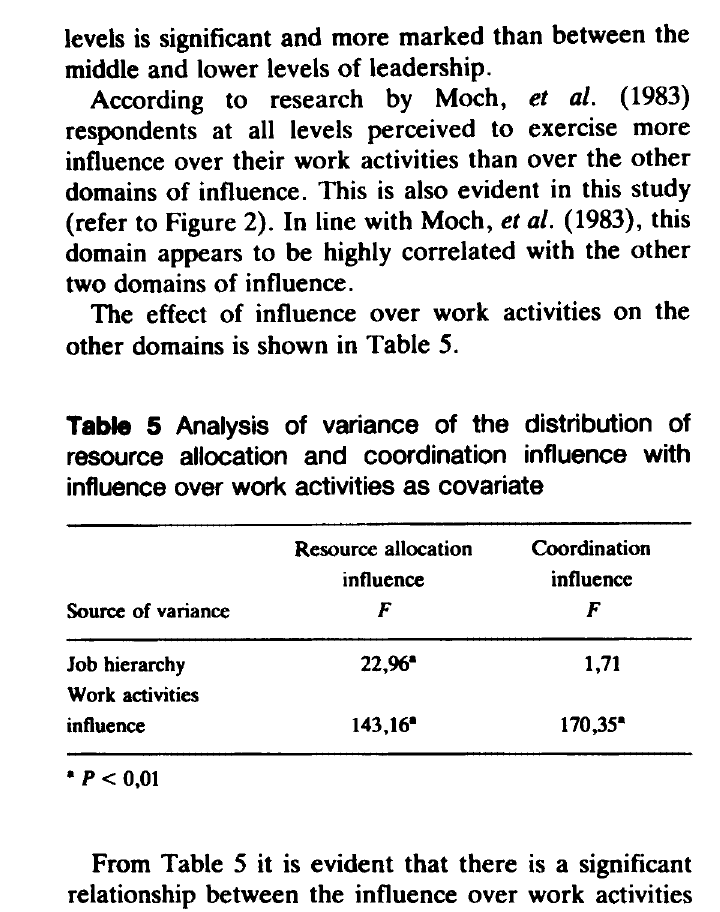
Table 5 Analysis of variance of the distribution of resource allocation and coordination influence with influence over work activities as covariate